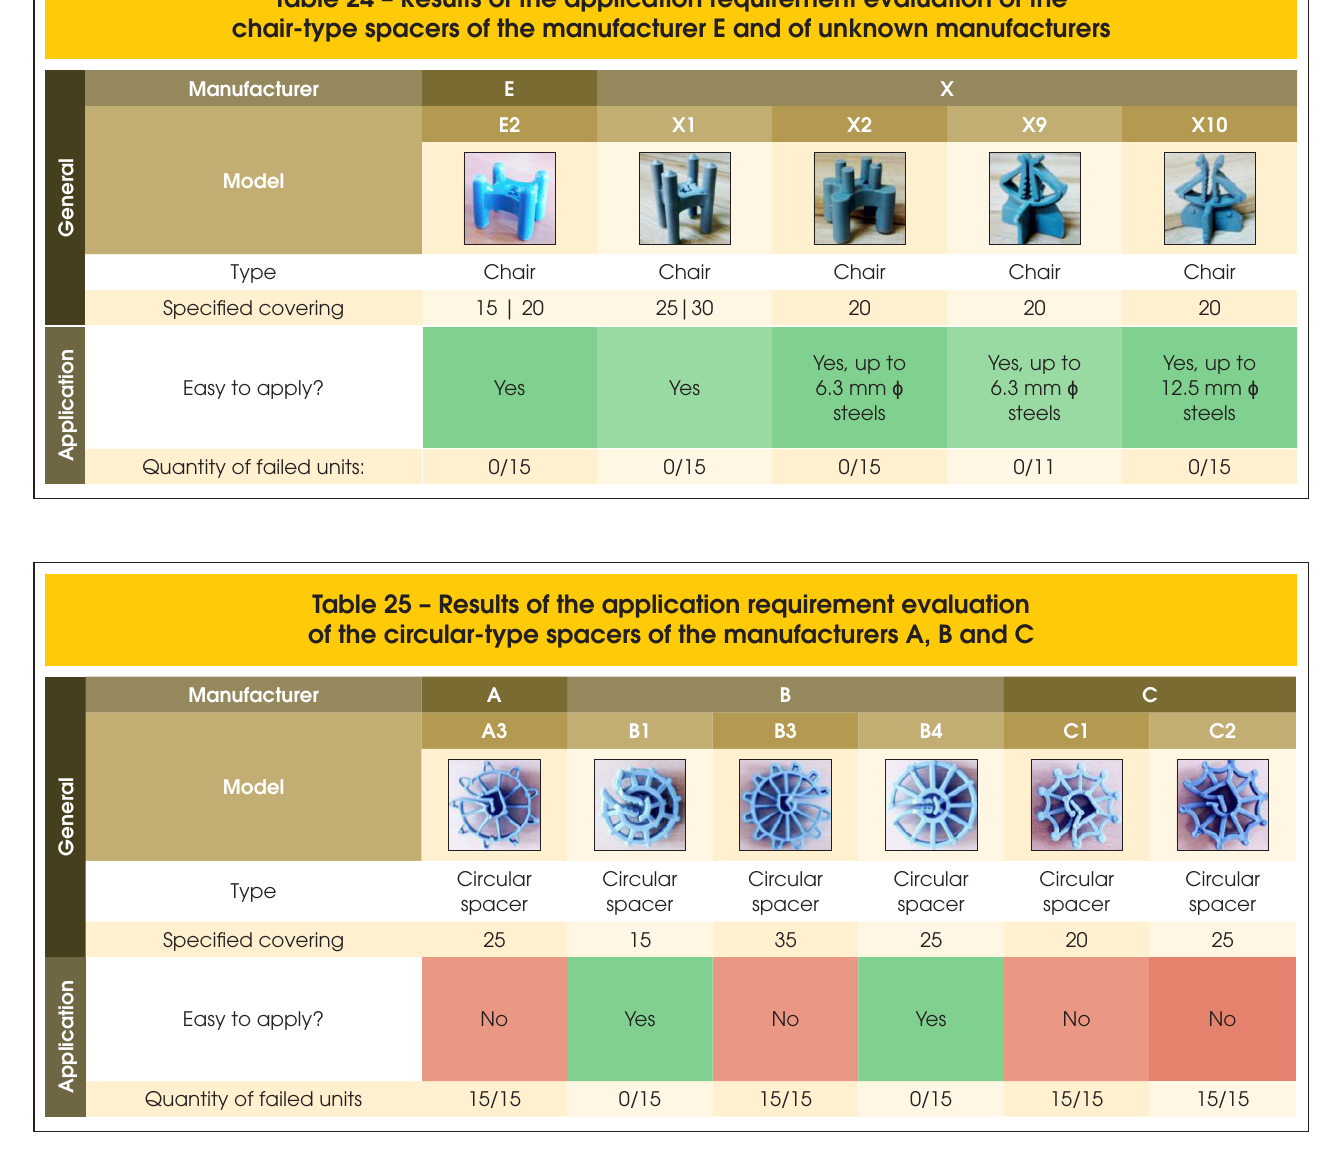
Table 24 – Results of the application requirement evaluation of the